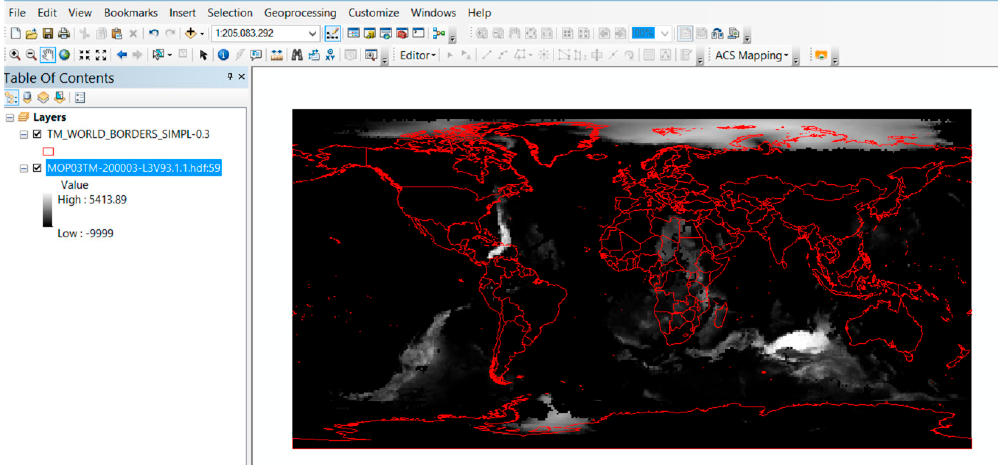
Figure 1. Rotated Earth Observation (EO) data in ArcGIS.